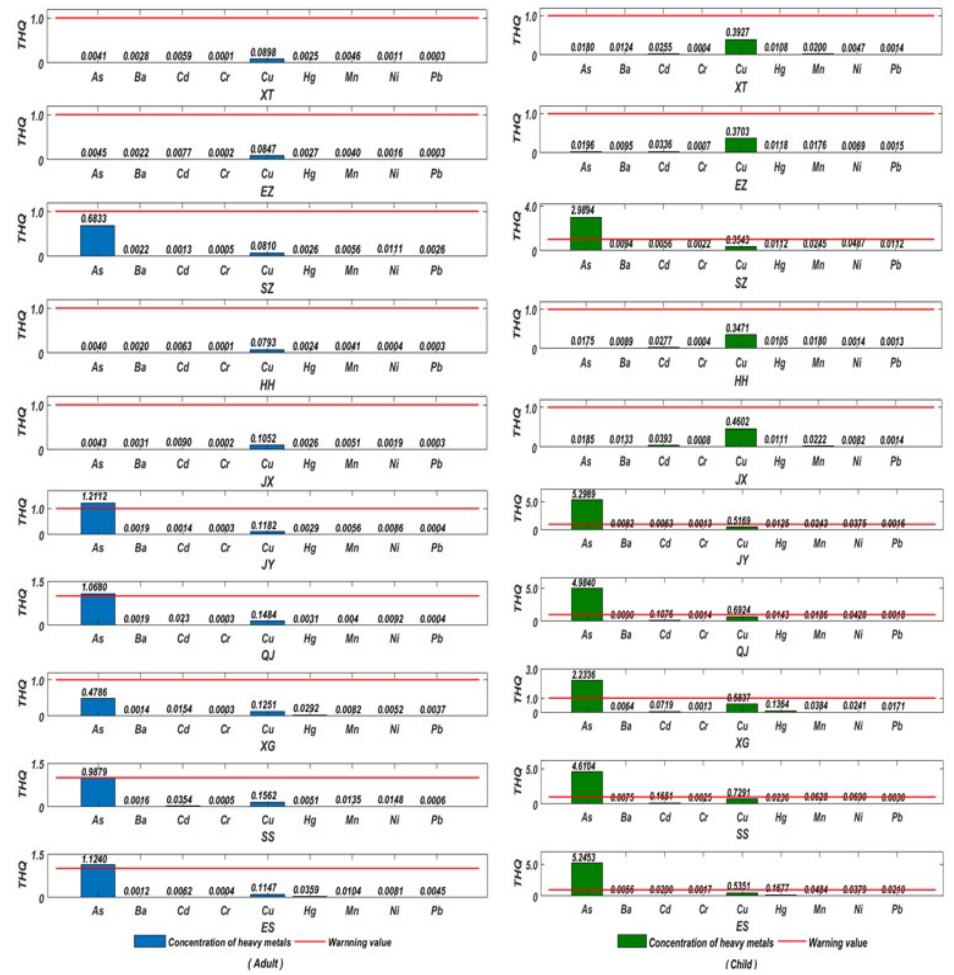
Figure 6. Adult/child hazard risk index of heavy metals in the abdominal muscles of crayfish.